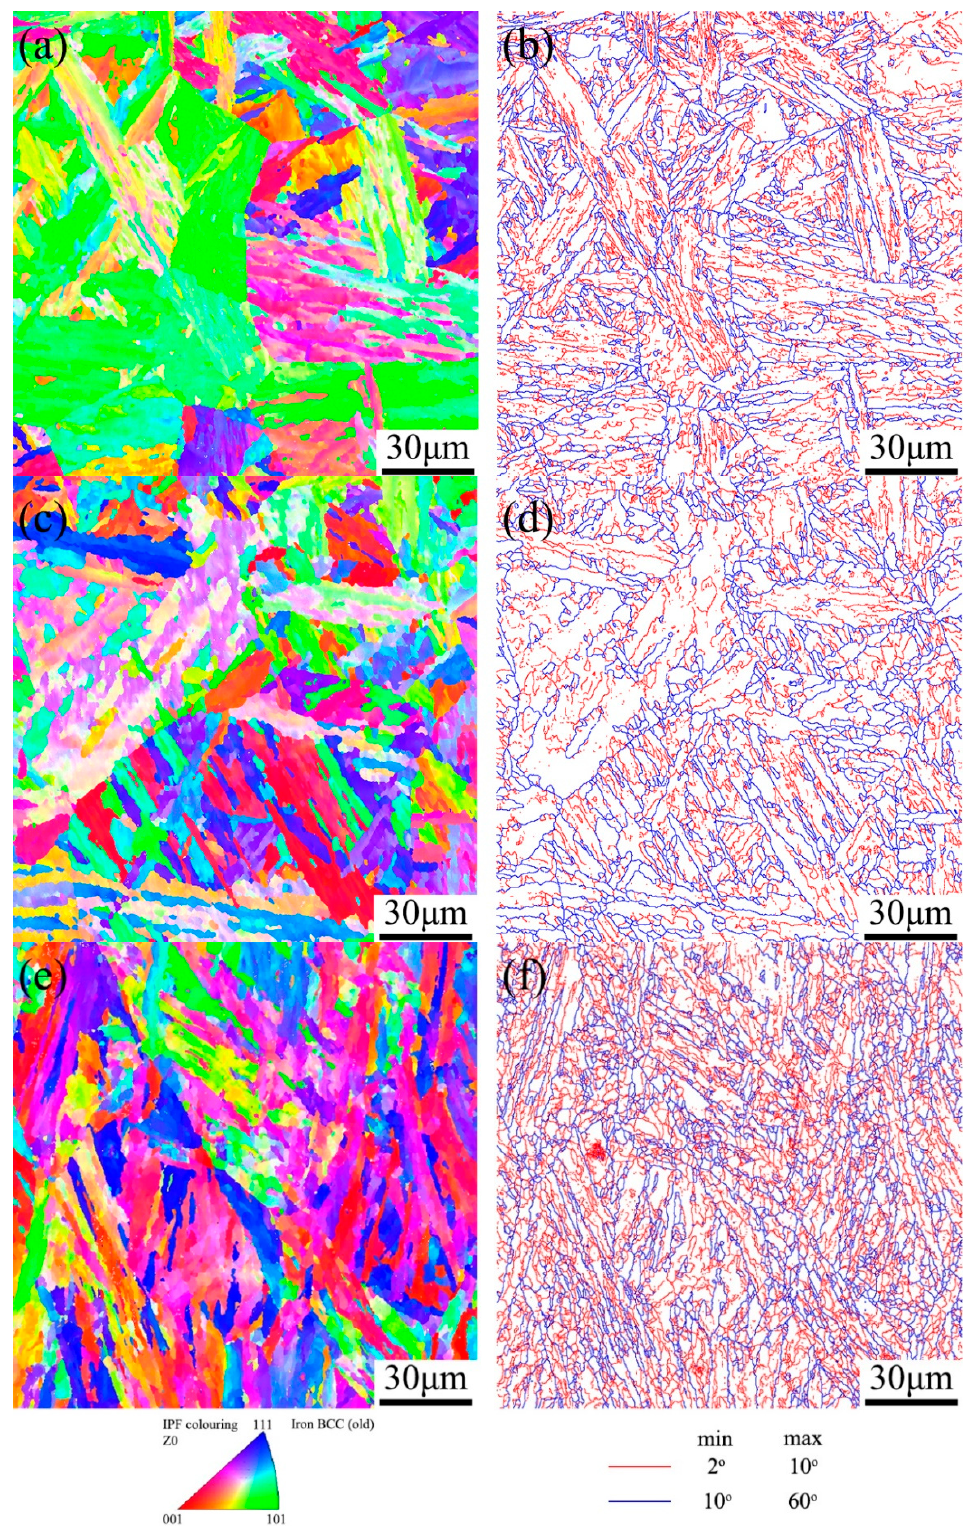
Figure 12. Electron back-scatted diffraction (EBSD) micrographs of 9Cr-3W-3Co steel crept at 650 °C for 18,551 h: ( a , c , e ) IPF figures, ( b , d , f ) boundary maps. ( a , b ) are from as-received specimen, ( c , d ) are from grip, ( e , f ) are from gauge.